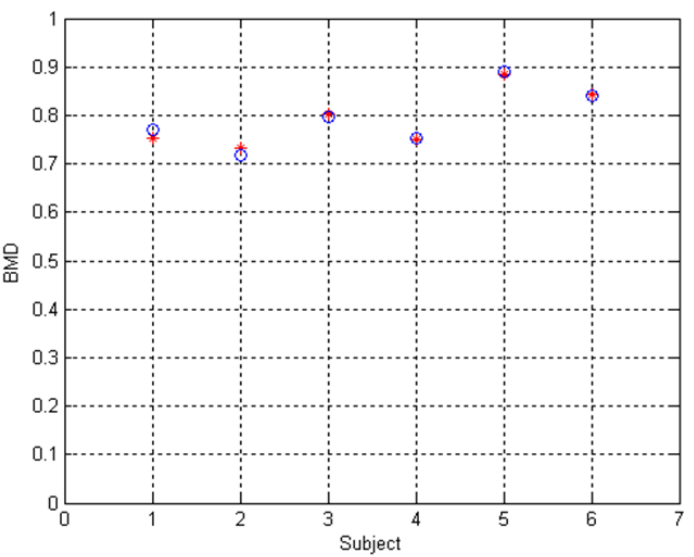
Figure 14. Plot of BMD computed from the proposed bone mineral density system (+) with measured by commercial bone mineral density system (o) after normalization.